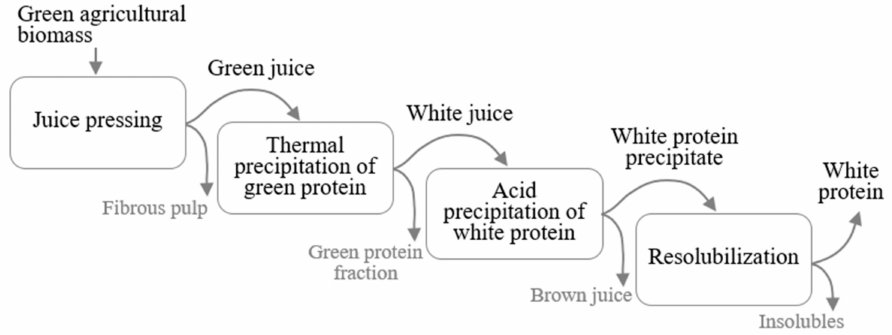
Figure 1. Main steps in a general process for producing white protein isolate from green agricultural